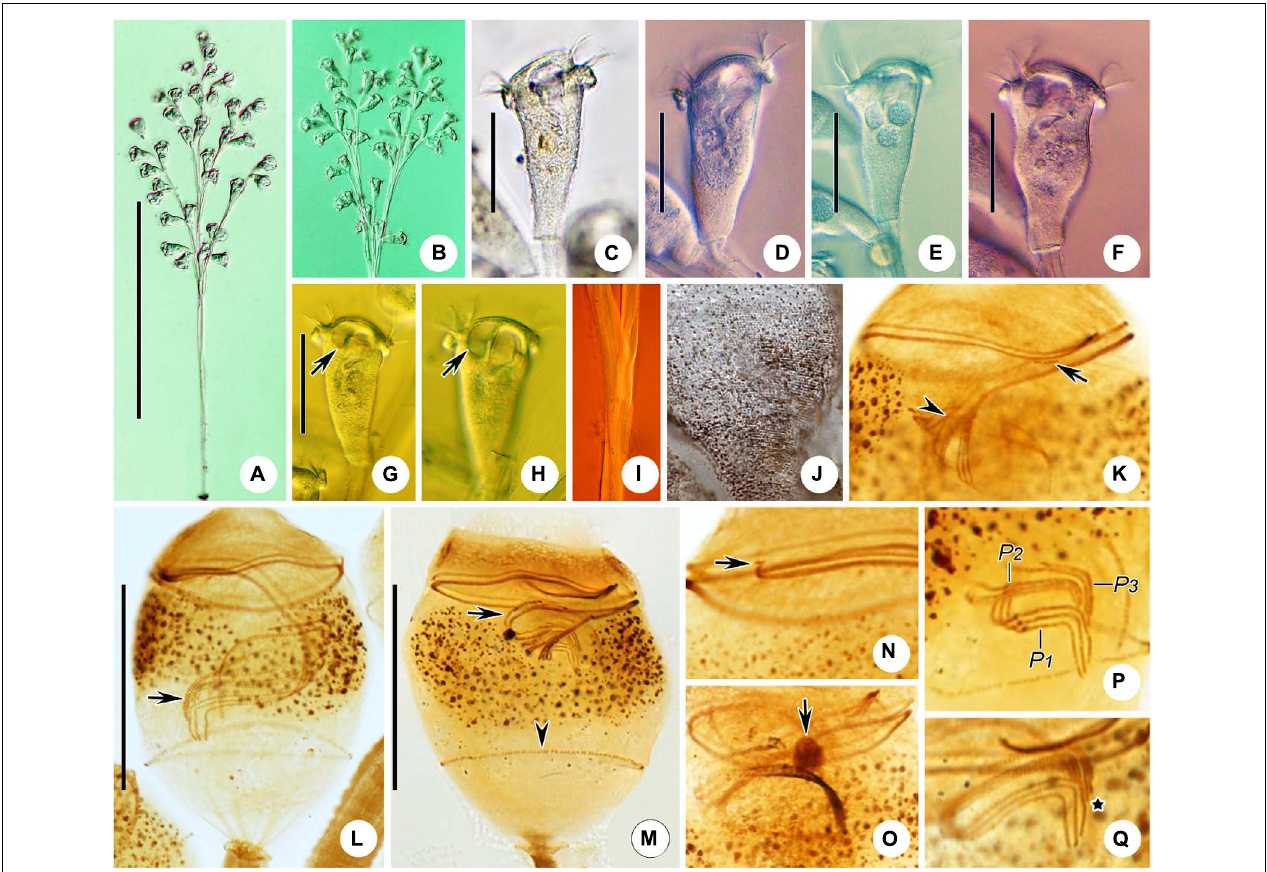
FIGURE 7 | Photomicrographs of Zoothamnium weishanicum n. sp. in vivo (A–I) , after “dry” silver nitrate staining (J) , and after protargol staining (K–Q) . (A,B) Two mature colonies. (C–H) Different zooids showing the shape variation; arrows mark the contractile vacuole. (I) Detail of stalk. (J) Silverline system. (K) Part of the oral ciliature; arrow marks epistomial membrane 1, and arrowhead marks the abstomal end of P2. (L,M) Two protargol-stained zooids showing the infraciliature; arrow in panel (L) marks P3, arrow in panel (M) marks the germinal kinety, and arrowhead in panel (M) marks the trochal band. (N) Part of the oral ciliature; arrow marks epistomial membrane 2. (O) Part of protargol-stained zooid; arrow marks the micronucleus. (P,Q) Infundibular polykineties 1–3 (P1–3); asterisk marks the adstomal end of P3. Bars: 700 µ m in panel (A) , 40 µ m in panels (C–G) , and 30 µ m in panels (L,M)